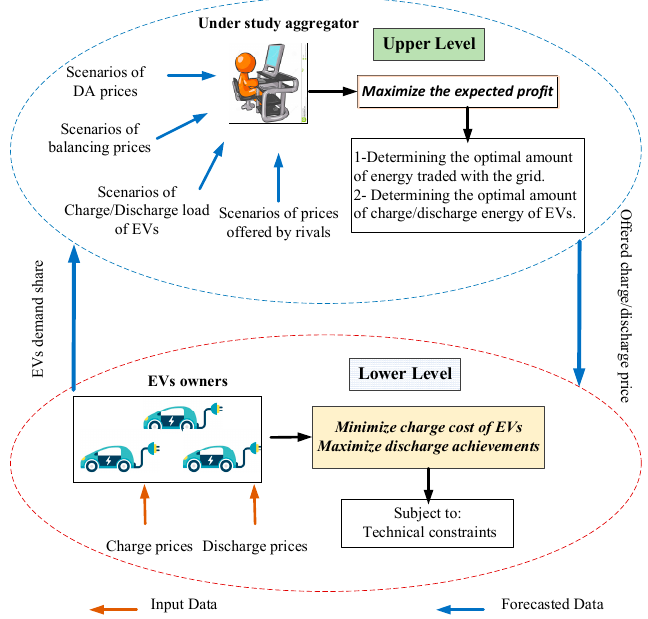
Figure 1. Bi-level structure of the proposed decision making for the electric vehicle (EV) aggregator in a competitive environment.